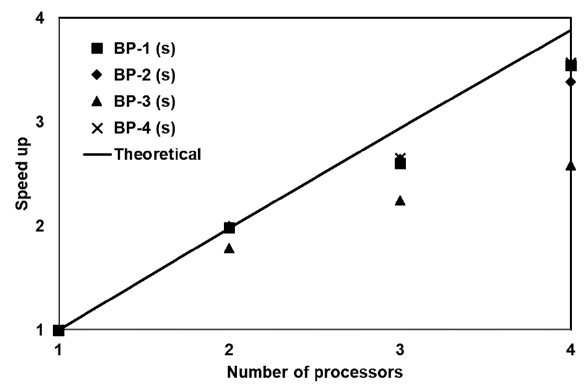
Figure 6. Speedup for all benchmark problems for different number of processors. Table 7. Simulation times for all the benchmark problems for different number of processors in seconds.